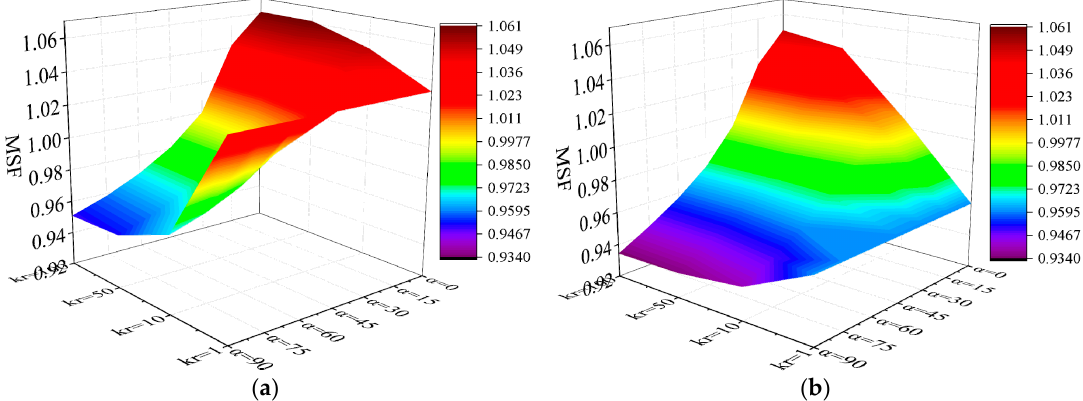
Figure 13. Minimum safety factor (MSF) of sandy and clay slope under different k r and α values. ( a ) Sandy slope . ( b ) Clay slope.